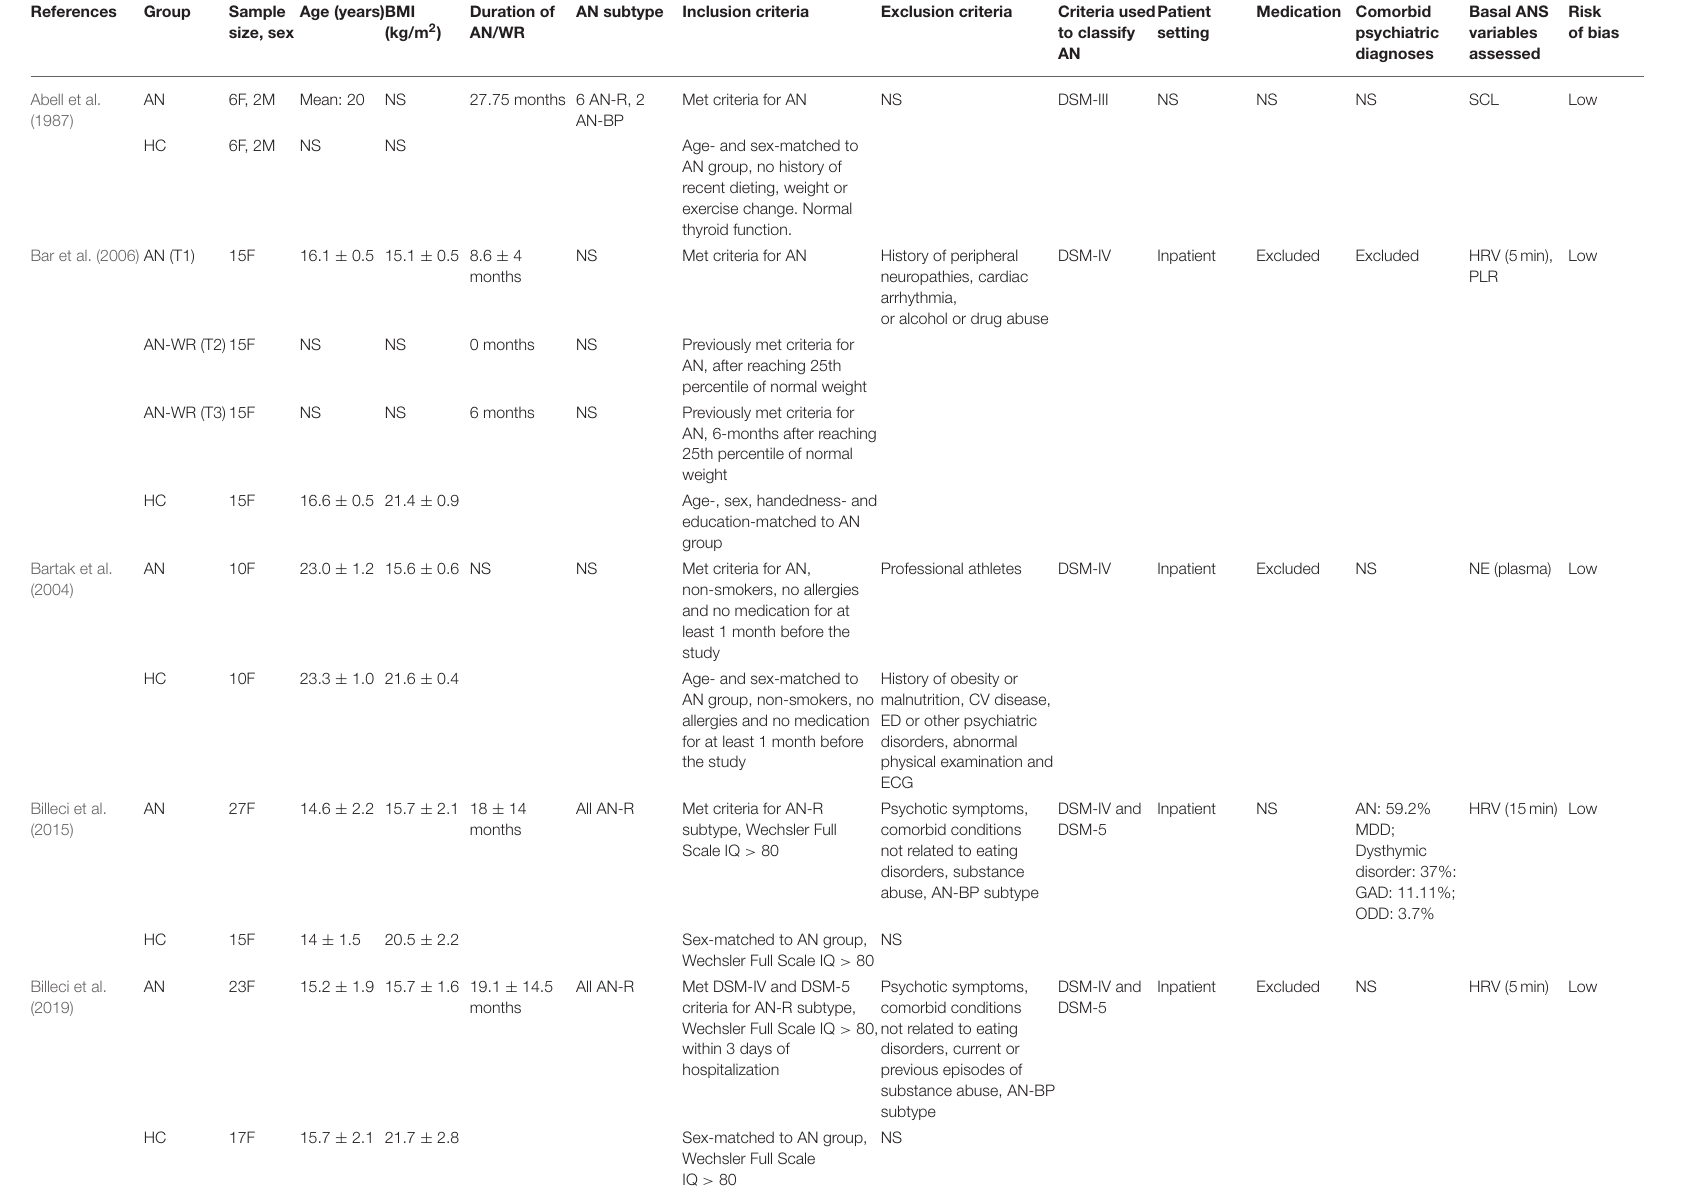
TABLE 2 | Characteristics of included